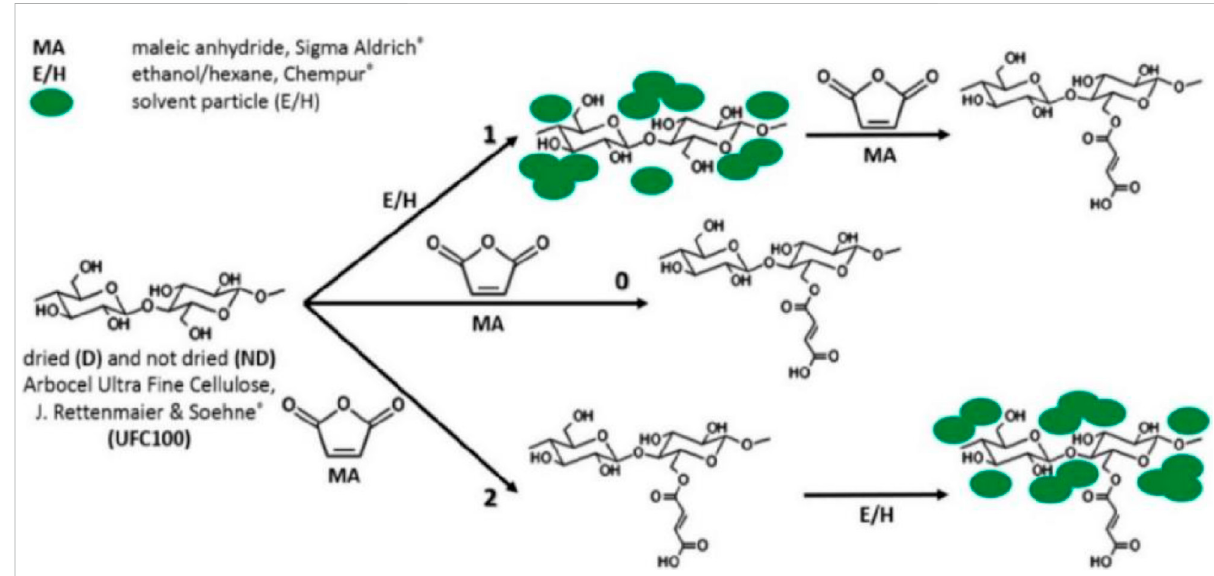
FIGURE 2 Hybrid chemical modi fi cation of cellulosic fi bers: pathway 0-regular surface modi fi cation with maleic anhydride (MA); pathway 1-solvent exchange before surface modi fi cation with MA; path 2-solvent exchange after surface modi fi cation with MA (Cichosz and Masek,